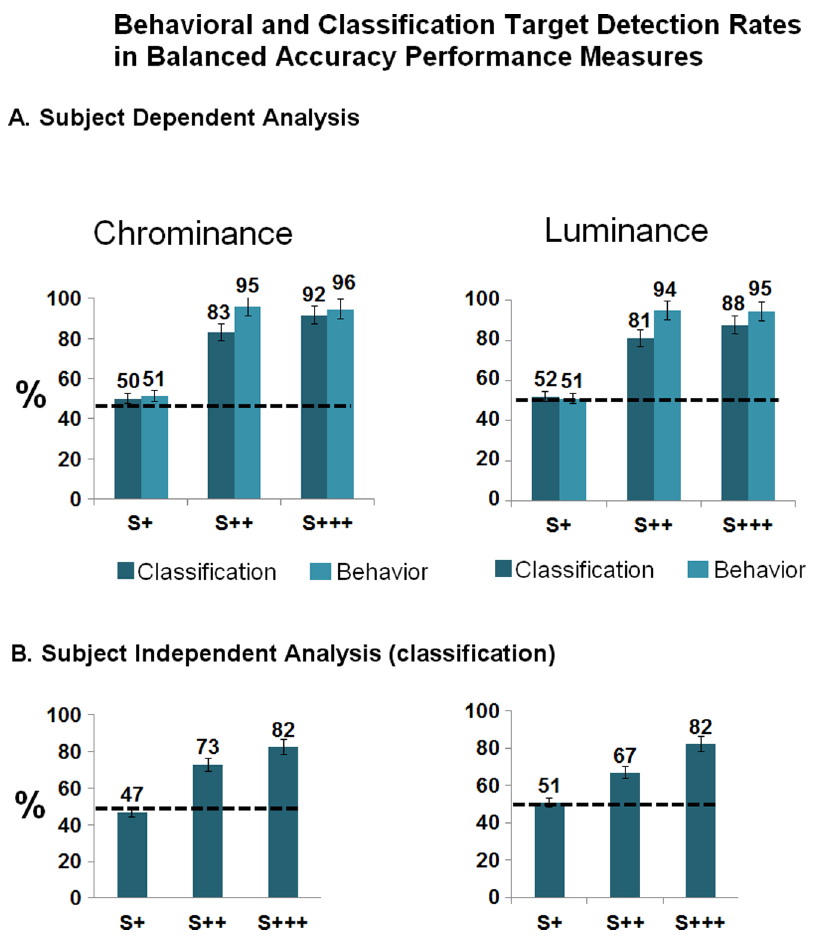
Figure 7. Behavioral and Singletrial waveform statistical classification performance in terms of (conservative) balanced accuracy – Experiments III & IV – we replicate the finding that single trial statistical classification matches conscious perception and can be generalized across subjects. A. Behavioral and Subject dependent (within subject classification) LOO Classification Accuracy Rates for Target detection. Right: results for the Chrominance experiment. Left: results for the Luminance experiment. B. Subject independent (between subject classification) LOO Classification Accuracy Rates for Target detection. Right: results for Chrominance condition. Left: results the Luminance experiment. Dashed lines depict chance level at 50%. Bars depict confidence intervals for the means at 95%.